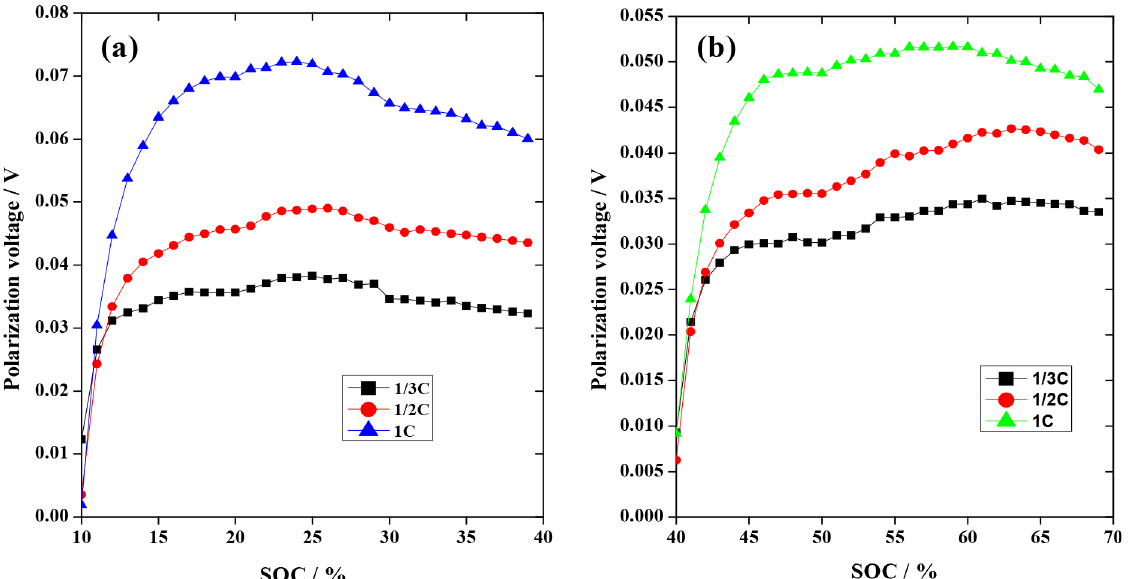
Figure 6. Polarization voltage vs. SOC profile at different charge currents. (a) initial SOC = 10%;